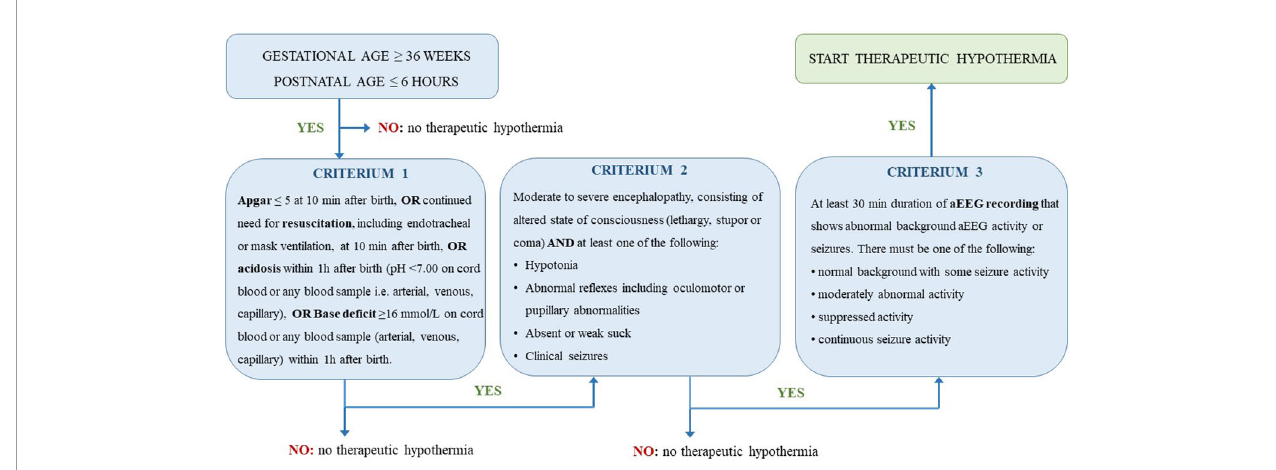
FIGURE 1 | Visual presentation of the sequential evaluation of the criteria used in the TOBY study to determine if therapeutic hypothermia needs to be started in neonates (Azzopardi et al.,